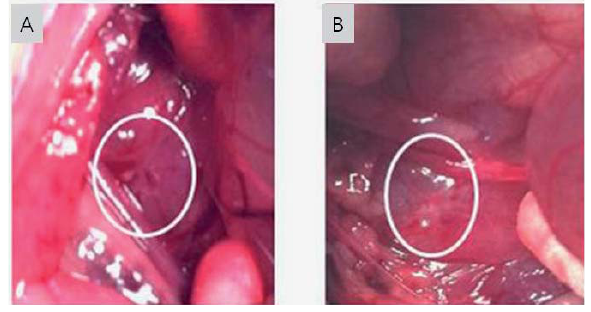
Figure 1 - The gross fi nding of MSCs plus collagen based cell carrier after immediate administration into MPG. A: MPG of normal rats, B: Gel formation of collagen based cell carrier contacting of MSCs after implantation, MPG: major pelvic ganglion, MSCs: mesenchymal stem